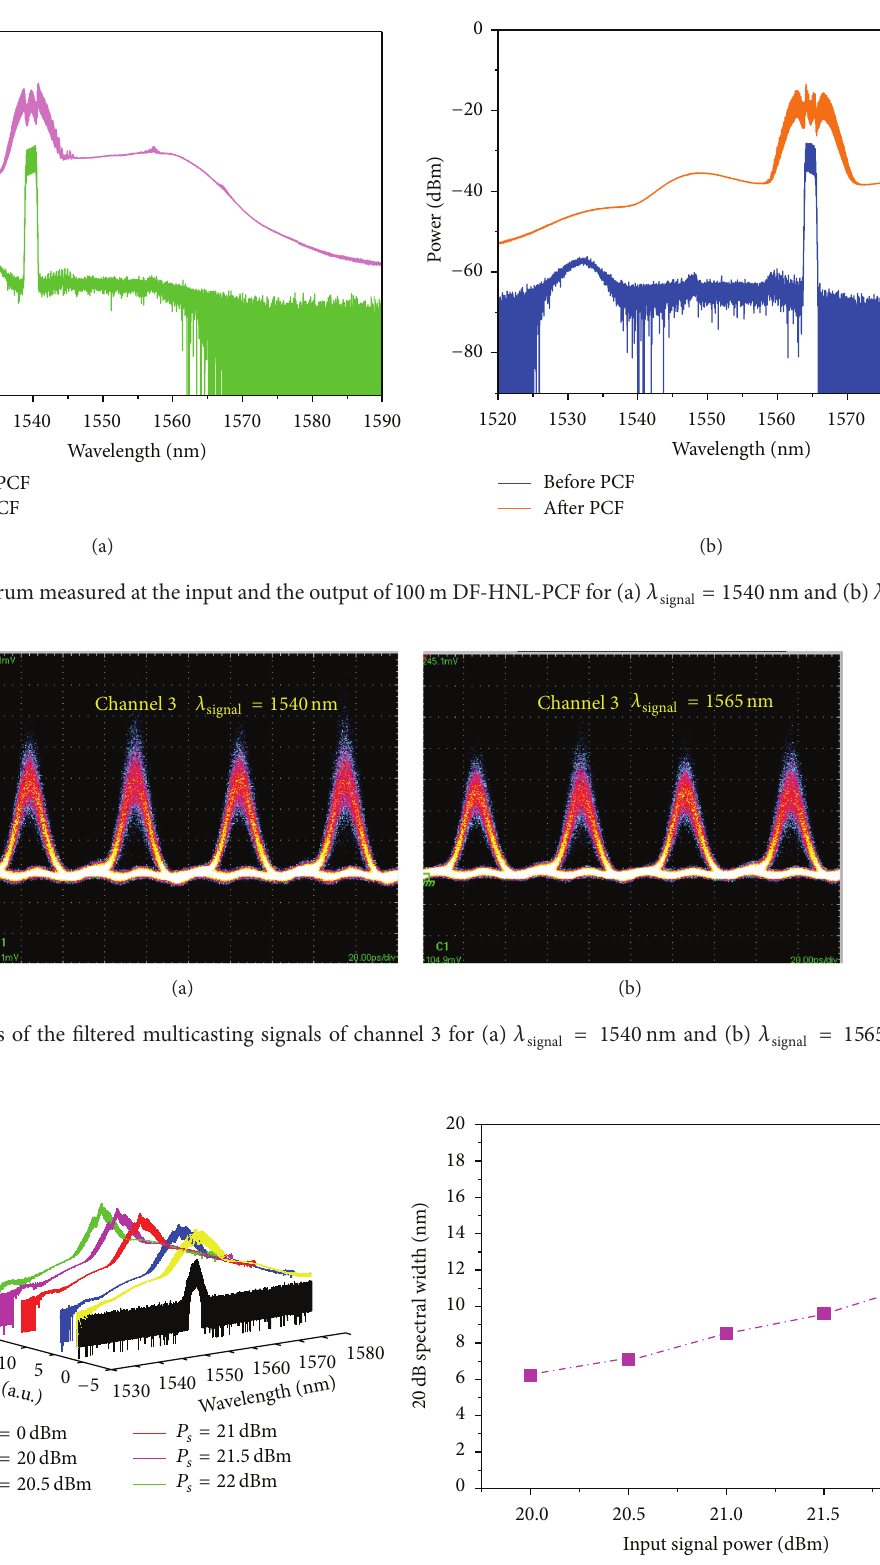
Figure 9: Spectrum characteristics of DF-HNL-PCF based wavelength multicasting scheme: (a) the SPM broadened spectrum and (b) 20 dB spectrum bandwidth versus input signal